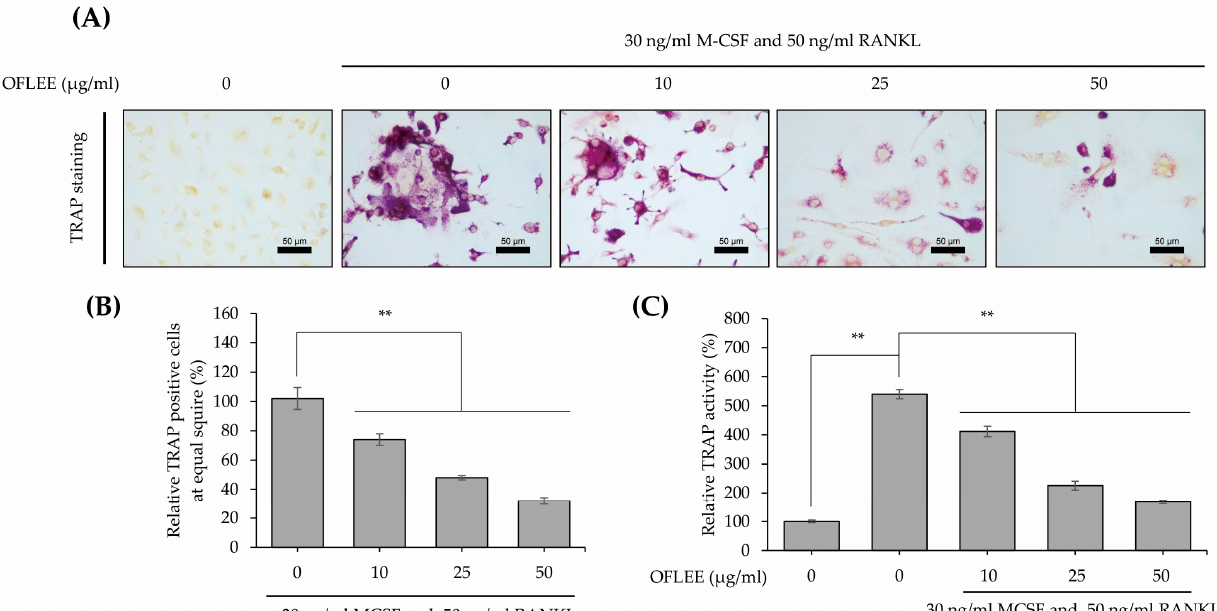
Figure 2. OFLEE suppresses TRAP-positive cells in the BMMs treated with M-CSF and RANKL. ( A ) OFLEE decreased the TRAP positive cells with multiple nuclei in the BMM treated with M-CSF and RANKL. ( B ) The number of TRAP positive cells were decreased by OFLEE treatment in the BMM treated with M-CSF and RANKL. ( C ) The OFLEE down-regulated TRAP activity in the BMM treated with M-CSF and RANKL. BMM was treated with 0, 10, 25, and 50 μ g/mL OFLEE in the presence of 30 ng/mL M-CSF and 50 ng/mL RANKL for 72 h. Thereafter, the TRAP staining and TRAP activity assay were performed using a TRAP and ALP double-stain kit, according to manufacturer’s instruction. Stained cells were photographed under a microscope. Thereafter, TRAP-positive cells were counted at equal areas. In addition, the TRAP activity was assessed by a microplate spectrophotometer. Results are mean ± SD of three independent experiments (n = 3), * p < 0.05 and ** p < 0.01.